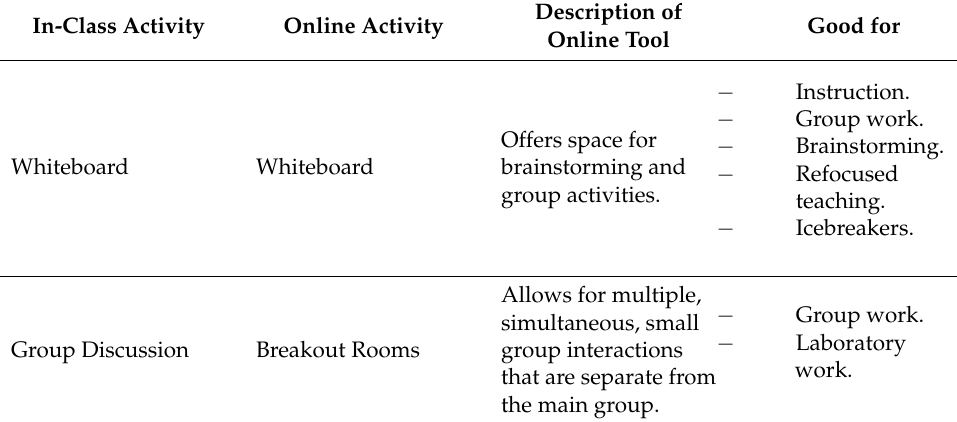
Table 1. Sample of active Learning Management System (LMS) tools a . In-Class Activity Online